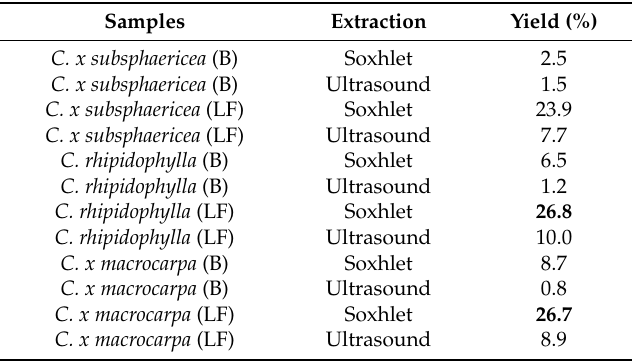
Table 1. Extract yield of the Crataegus